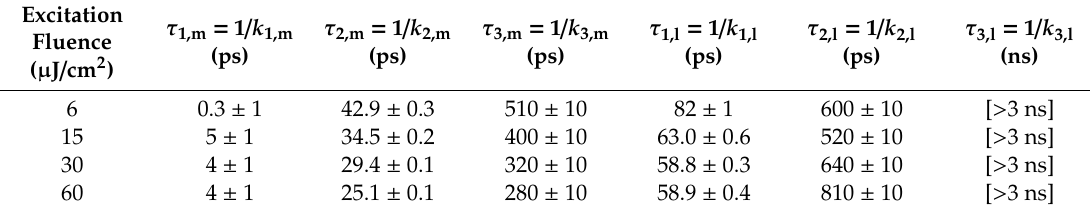
Table 3. Fit parameters for a tri-exponential decay extracted from global analysis at different excitation fluences.